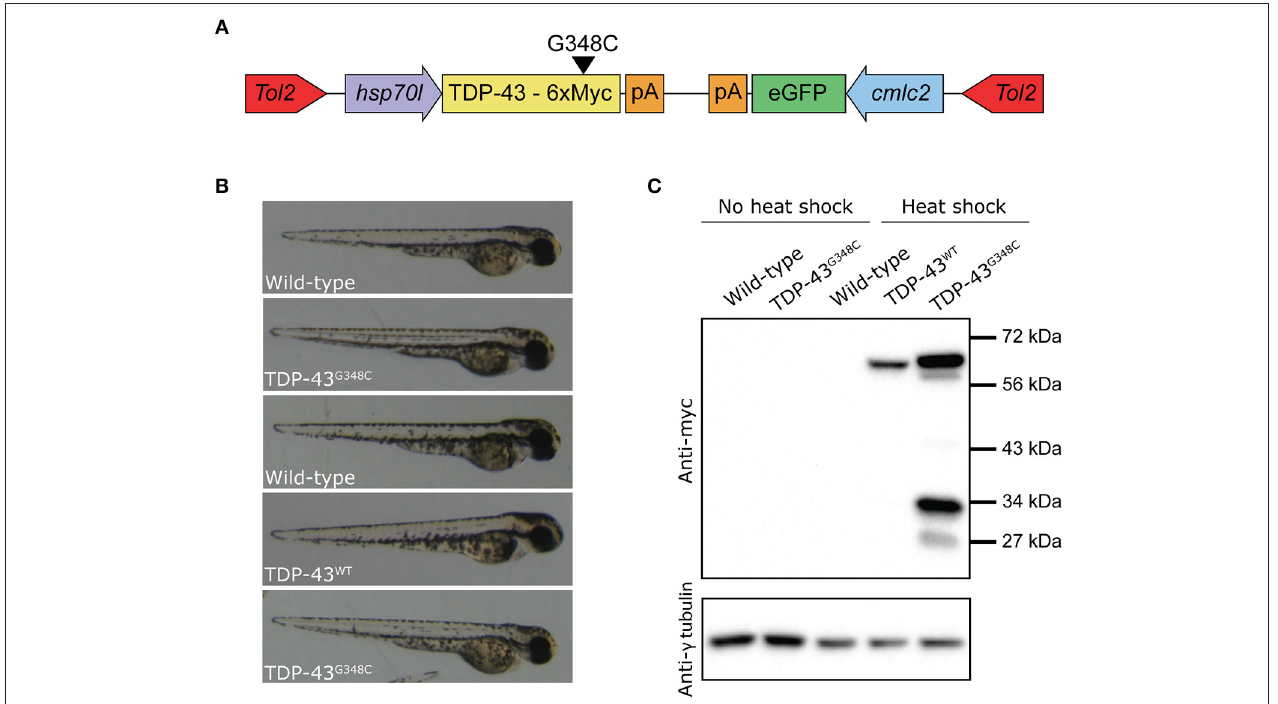
FIGURE 1 | Generation of zebrafish transgenic lines expressing wild type and mutant human TDP-43. (A) The transgene constructs consist of the human wild type (TDP-43 WT ) or the G348C mutant TDP-43 (TDP-43 G348C ) cDNA fused with 6 myc-tag under the control of the hsp70-like promoter ( hsp70l ). The constructs also contained eGFP driven by the cardiac myosin light chain ( cmlc2 ) promoter. (B) Representative picture of the embryos used for all experiments. (C) Western blot showing expression of the human transgene in 2 days post-fertilization (dpf) embryos following a 1h heat shock at 38.5 ◦ C using an anti-myc antibody.